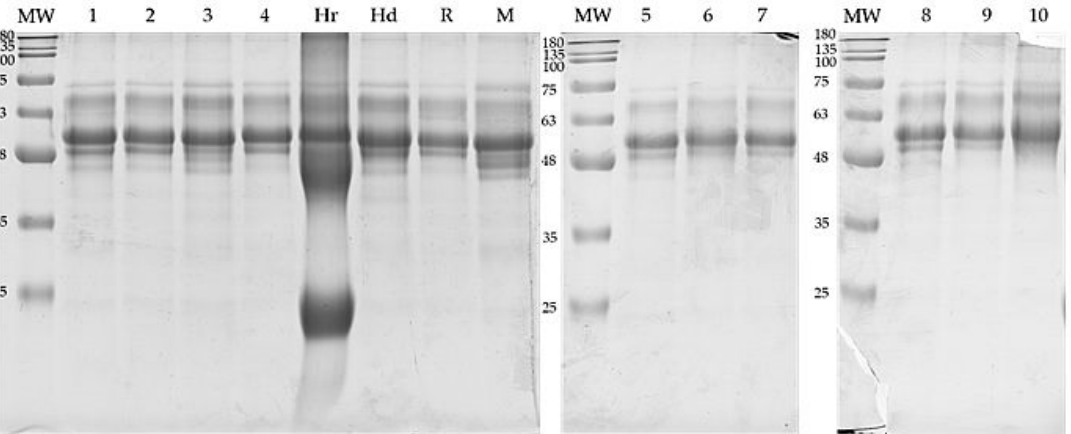
Figure 2. Protein profiles of analyzed goldenrod honey samples in comparison to other